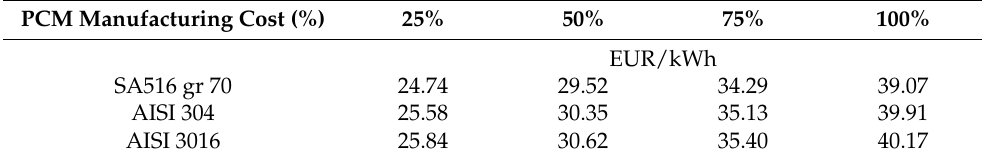
Table 9. PCM manufacturing variation impact to the total